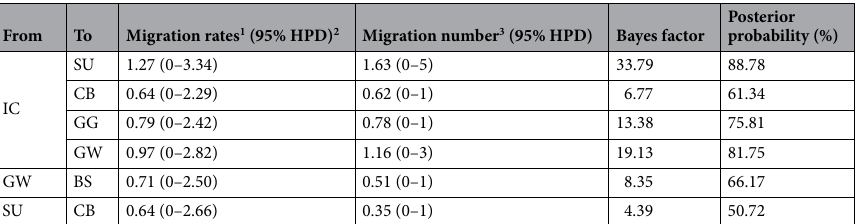
Table 3. Migration rates, migration number, Bayes factor, and posterior probability of spread of the Kor- O2 subgroup in South Korea. Only well-supported viral migrations (posterior probability > 0.5 and Bayes factor > 3) are displayed in this table. IC Incheon, SU Seoul, CB Chungcheongbuk-do, GG Gyeonggi-do, GW Gangwon-do, BS Busan. 1 Actual migration rates were calculated as rate × indicator. 2 95% HPD, 95% height posterior density. 3 Number of migrations among regions in phylogenetic tree (Markov jumps) were estimated using stochastic mapping techniques implemented in the BEAST package.